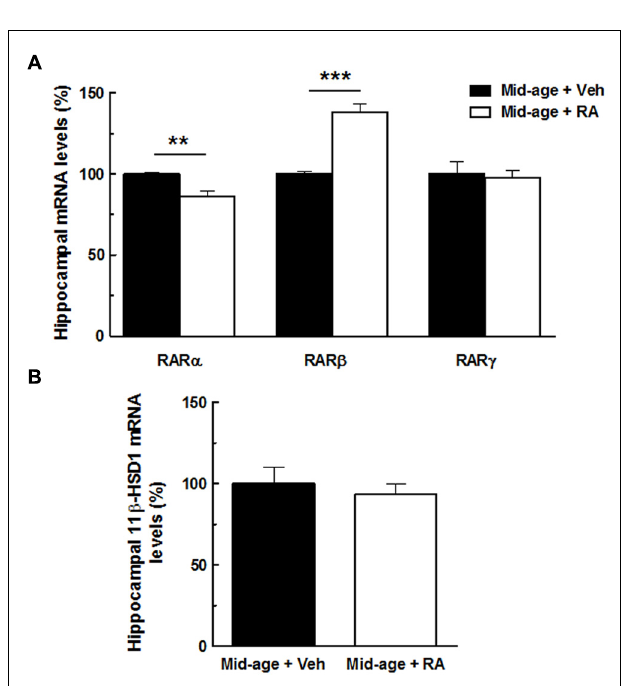
FIGURE 5 | Effects of RA treatment on hippocampal CORT release. (A) Histological control of intra-hippocampal microdialysis probe implantation. Photomicrograph ( × 20) of coronal brain section stained with cresyl violet. Stereotaxic coordinates from bregma: AP = − 2000 μ m, L = ± 1400 μ m, and V = − 900 μ m. (B)